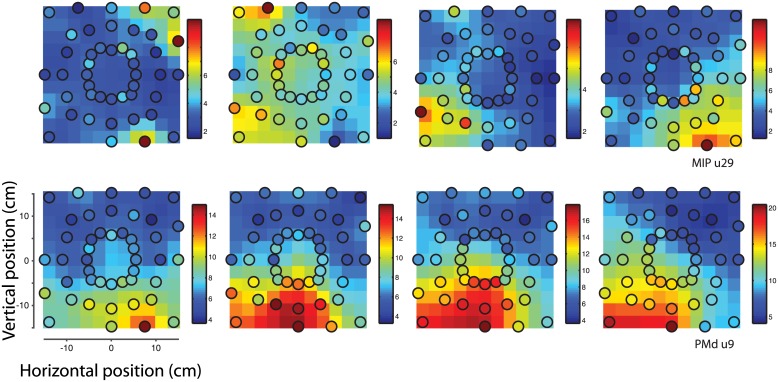
Example spatial response patterns.Each row shows the spatial response patterns of an example neuron, for each epoch considered. One example neuron from each area is shown. The measured average firing rates at spatial positions of the reach target are plotted (colored circles) overlaid on the interpolated spatial response pattern (11x11 colored maps), using the same color scale. Warmer colors indicate higher firing rates. For visualization purposes, the interpolated spatial response patterns have been slightly smoothed, using a two-dimensional Gaussian kernel of width 0.5 bins.